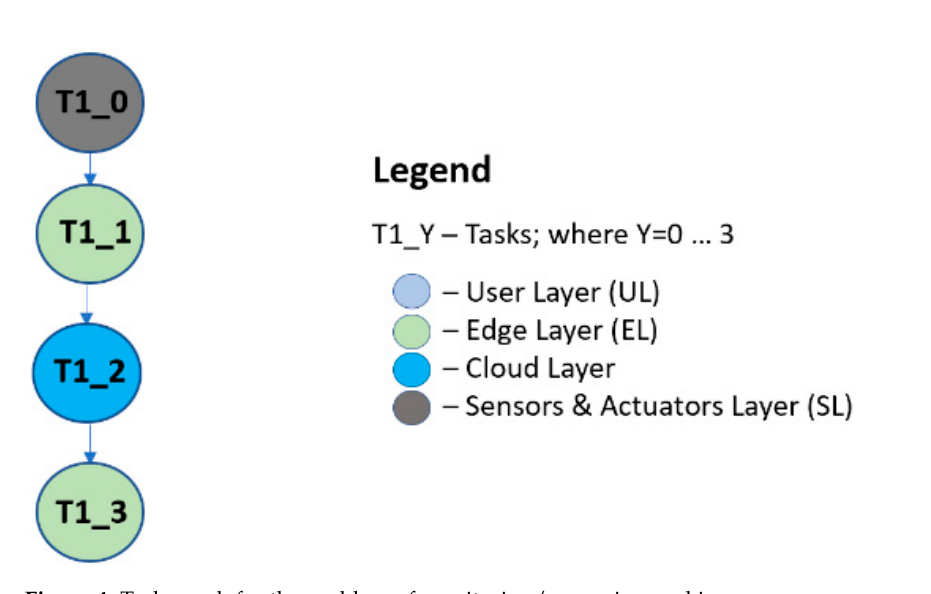
Figure 3. Task graph of the parking space management system.